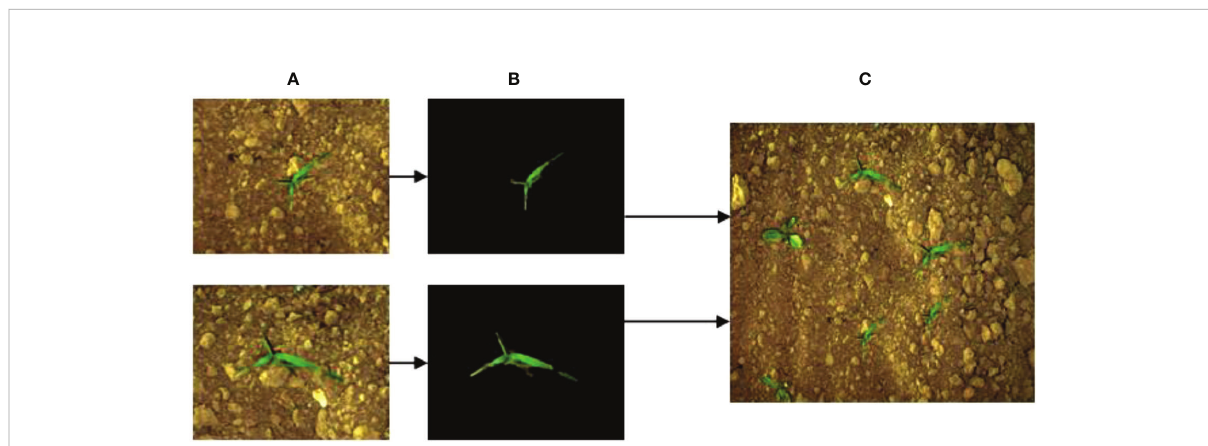
FIGURE 6 Image augmentation process for increasing the number of weed objects. (A) Sub-image containing only weeds and background, (B) Extracted weed pixels, (C) Synthetic new images containing more weed objects.